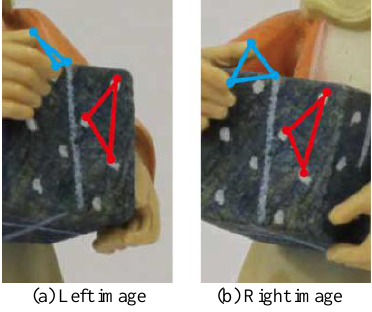
(a) Left image (b) Right image Figure 7. Difference in color information.